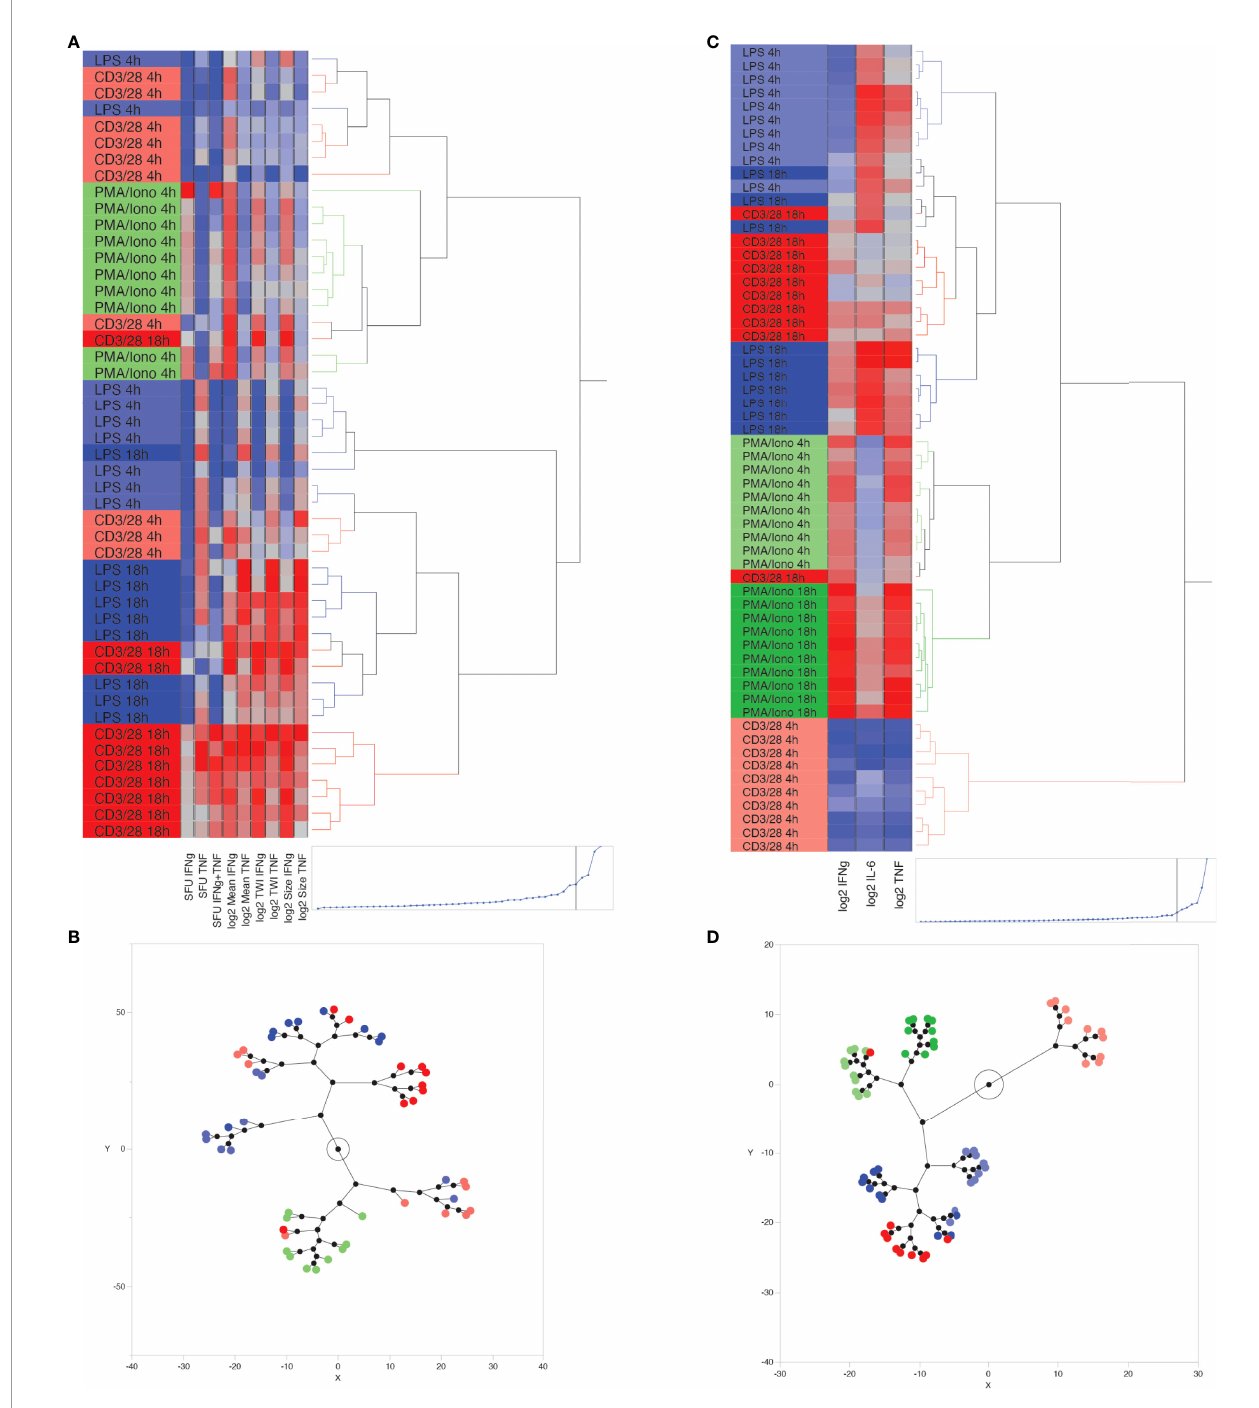
FIGURE 4 | Unsupervised, hierarchical cluster analysis using Ward ’ s minimum variance method, to predict ex vivo stimulant by using ELLA versus ELISpot data from 10 healthy volunteers. (A) Dendrogram with heat map demonstrating hierarchical clustering by using ELISpot-derived SFU, log 2 -TWI, MSI and MSS, (B) Constellation plot showing data derived from Figure 4B , (C) Dendrogram with heat map demonstrating hierarchical clustering by using ELLA-derived, log 2 - transformed, plasma cytokine concentrations for Interferon (IFN) g , Tumor Necrosis Factor (TNF), and interleukin (IL)-6, (D) Constellation plot showing data derived from Figure 4C